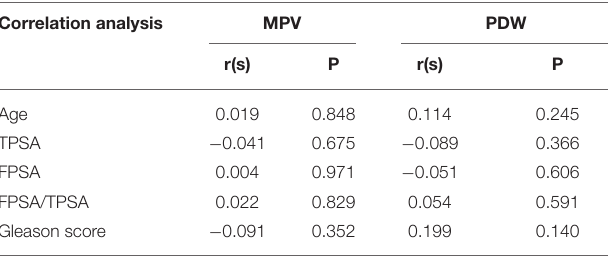
TABLE 3 | Correlation analysis between MPV or PDW and age, TPSA, FPSA, FPSA/TPSA and Gleason score in PCa patients. Correlation